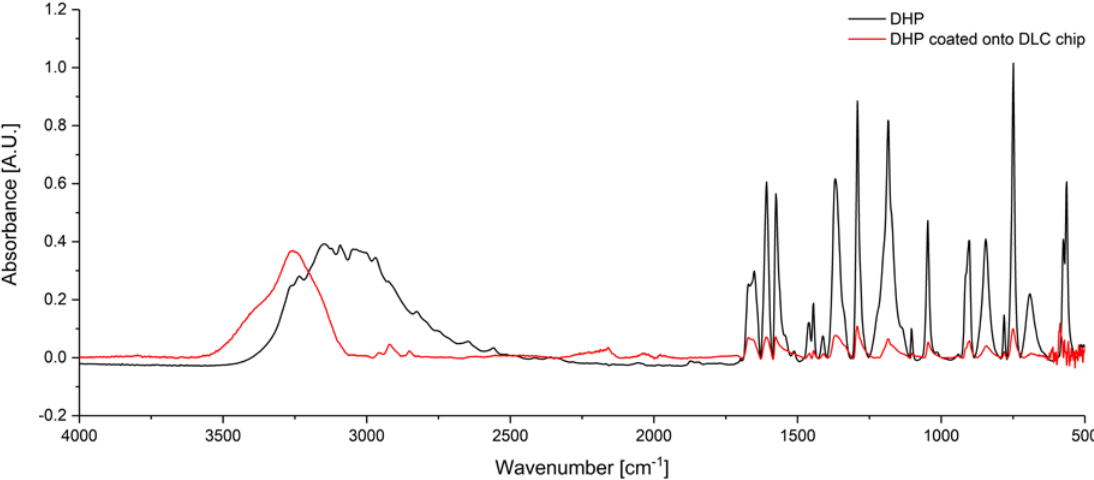
Figure 3. MIR spectrum of solid DHP (black) and 13 mg/mL DHP onto DLC layer (red).